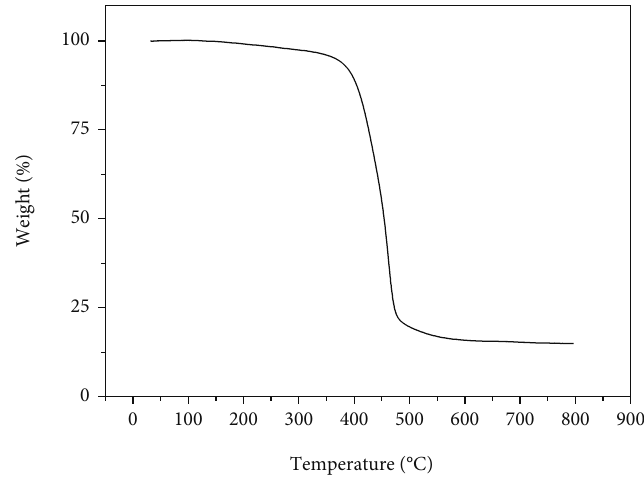
Figure 2: Thermogravimetric analysis of the polymer.